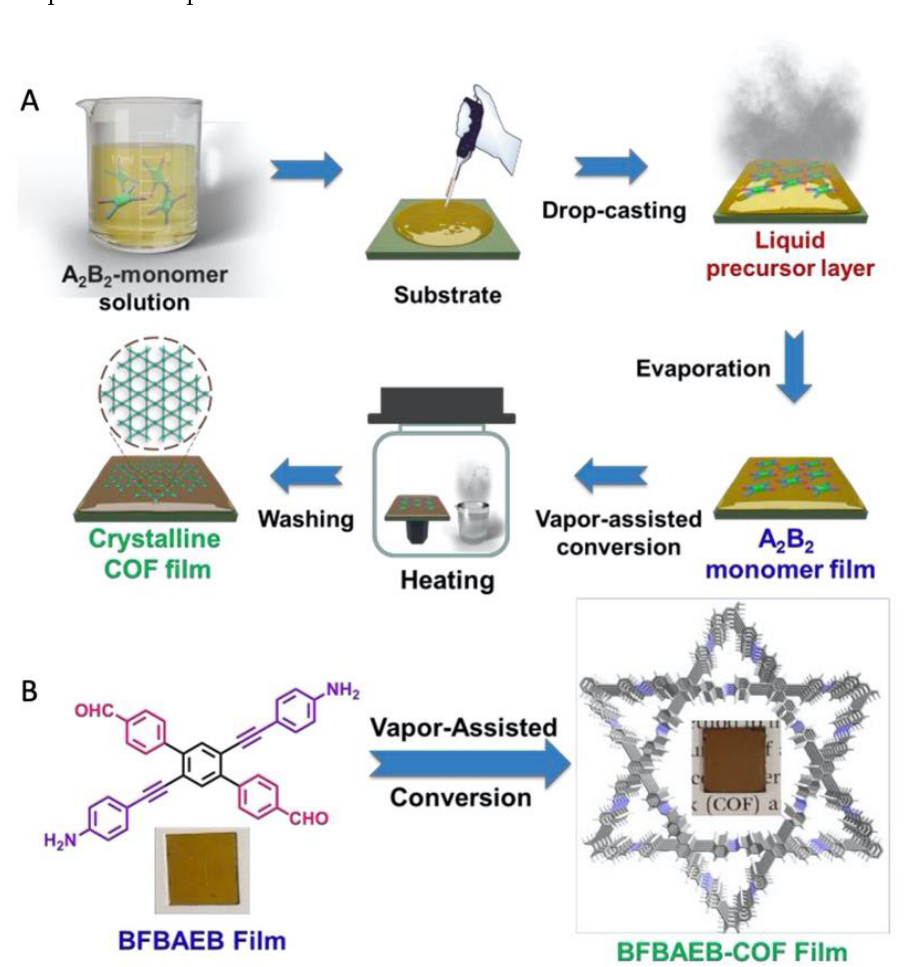
Figure 3. ( A ) Schematic description of vapor-assisted conversion of monomer film to COF film and ( B ) the pictures of monomer film and COF film (reproduced from Ref. [55] with permission CCS Chemistry).